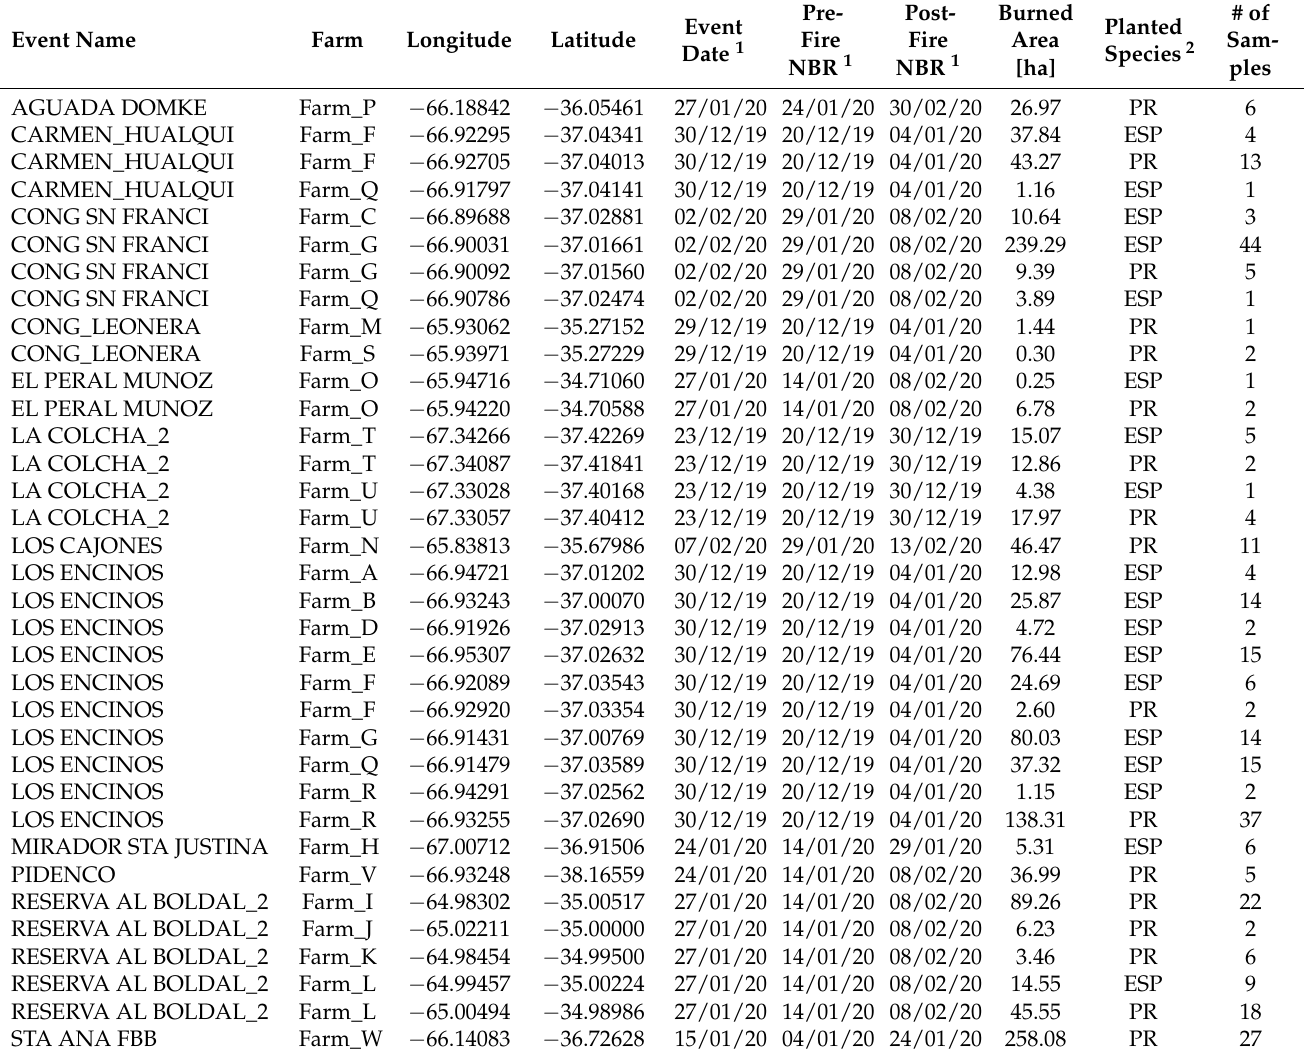
Table 1. Wildfire events sampled during the summer seasons of 2019–2020. The table shows the farm affected, the area affected by fire, species present, and number of sampling